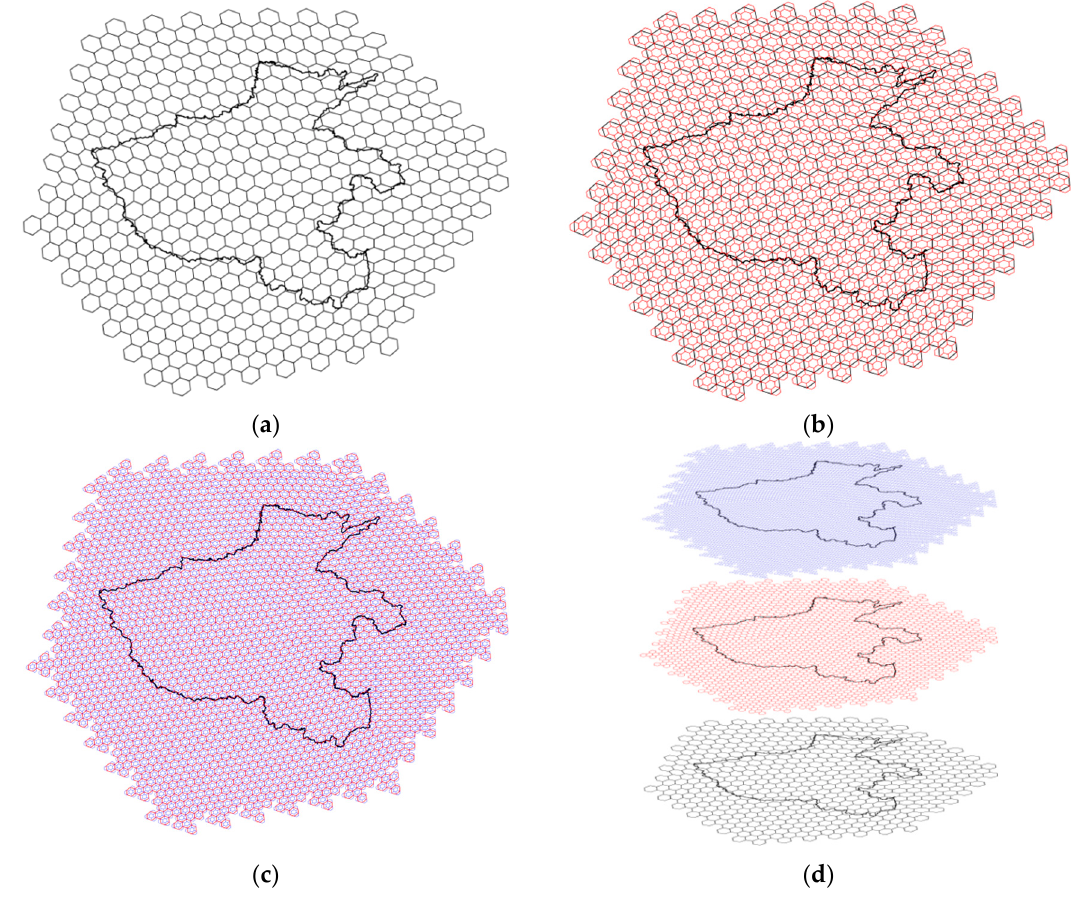
Figure 8. Hierarchical indexing algorithm and pyramid model: ( a ) the indexing result of level 10 grids (initial resolution); ( b ) indexing from grid levels 10 to 11; ( c ) indexing from levels 11 to 12; and ( d ) the pyramid model of the hierarchical index algorithm.